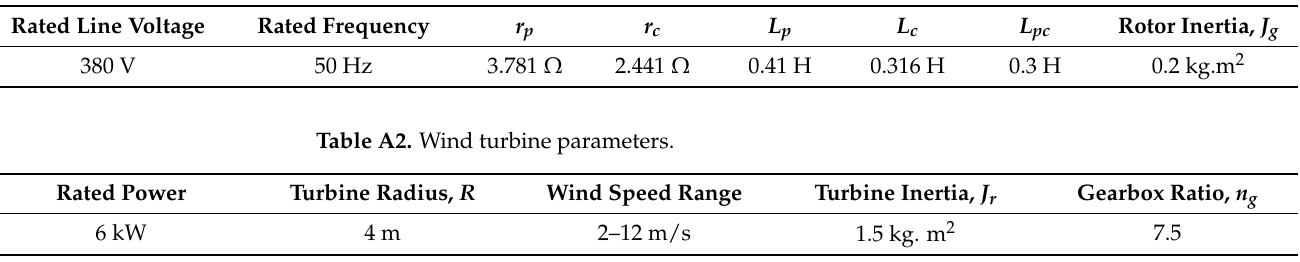
Table A1. BDFRG parameters.